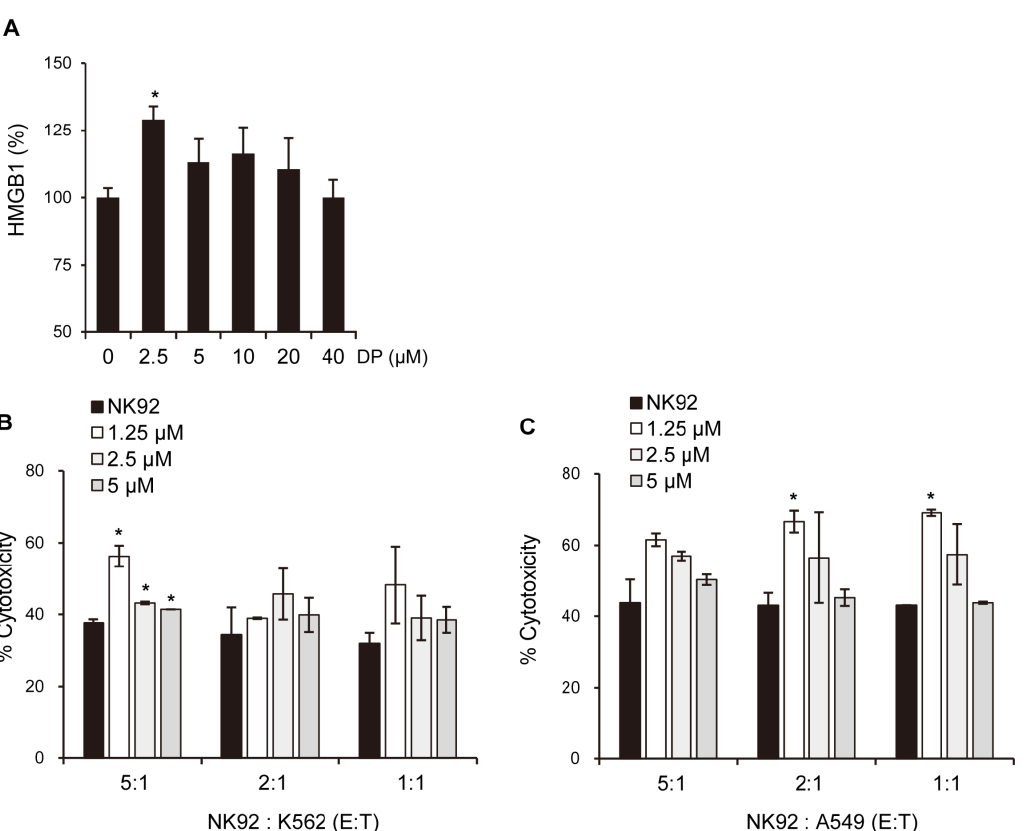
Figure 10. DP releases HMGB1 and enhances cytotoxicity in NK-92 cells. ( A ) The secreted HMGB1/HMG-1 levels were measured using ELISA. ( B , C ) To assess the effect of HMGB1-containing supernatant from DP-treated A549 cells on NK cell activity, NK-92 cells were co-cultured with K562 cells and A549 cells. All data are expressed as the mean ± SD obtained from at least three independent experiments. Statistical differences were analyzed by two-way ANOVA with Tukey’s multiple comparisons test and presented as p < 0.05 (*) compared with the control.